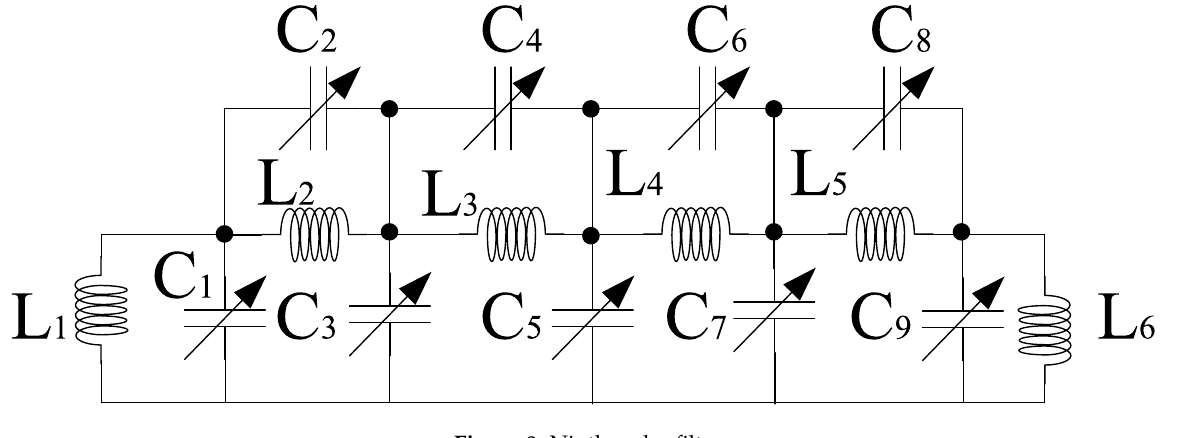
Figure 8. Ninth-order filter.